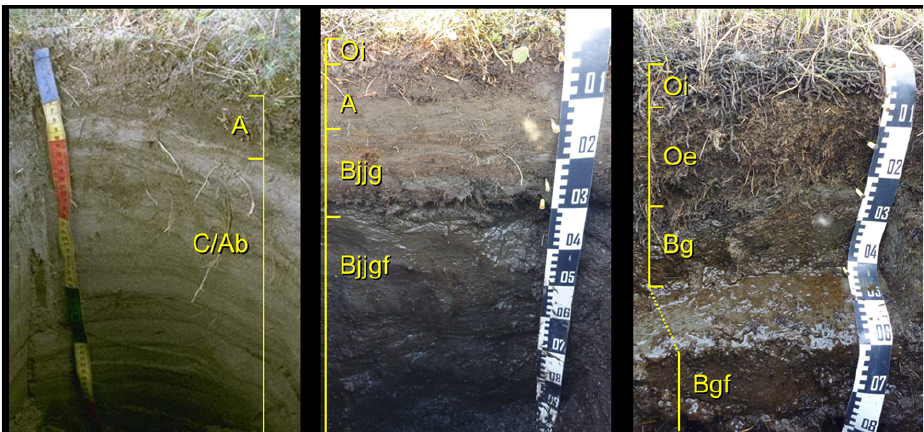
Fig. 4. Photos of three typical soils at Samolyov Island. (a) Typic Psammorthel, floodplain, natural levee, 2001; (b) Typic Aquiturbel, first terrace, polygon rim, 2012; (c) Typic Historthel, first terrace, polygon centre, 2012. Typical soil properties of such soils are given in Table